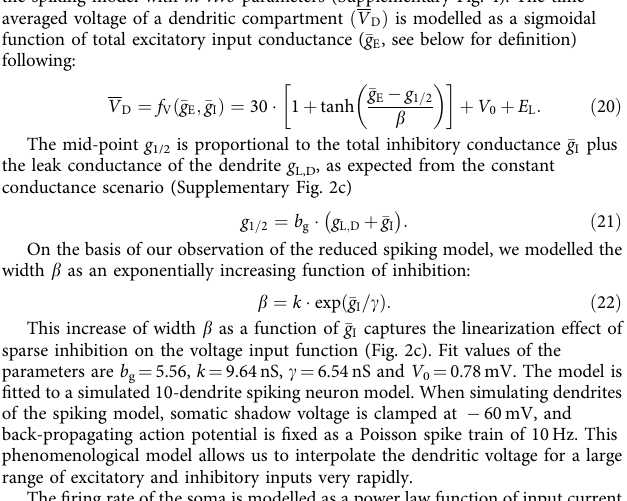
For Fig. 3, excitatory pathways can overlap. In the context with gate 1 open, N disinh dendrites are disinhibited. Excitatory pathway 1 targets these N disinh dendrites, each with strength 25nS, and similarly for gate 2 and pathway 2. The N disinh dendrites disinhibited for gate 2 are chosen randomly and independently from the N disinh dendrites disinhibited for gate 1. For each N disinh and N dend , r on and r off are averaged across all possible projection patterns. Rate pyramidal neuron model . The rate model is fitted with simulation data from the spiking model with in vivo parameters (Supplementary Fig. 4). The time- averaged voltage of a dendritic compartment ð V D Þ is modelled as a sigmoidal function of total excitatory input conductance ( (cid:2) g E , see below for definition) following: